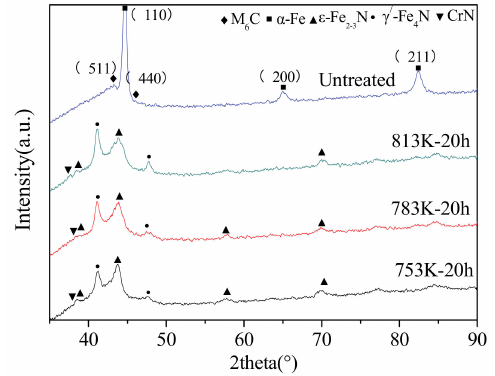
Figure 5. XRD profiles of untreated and plasma-nitrided